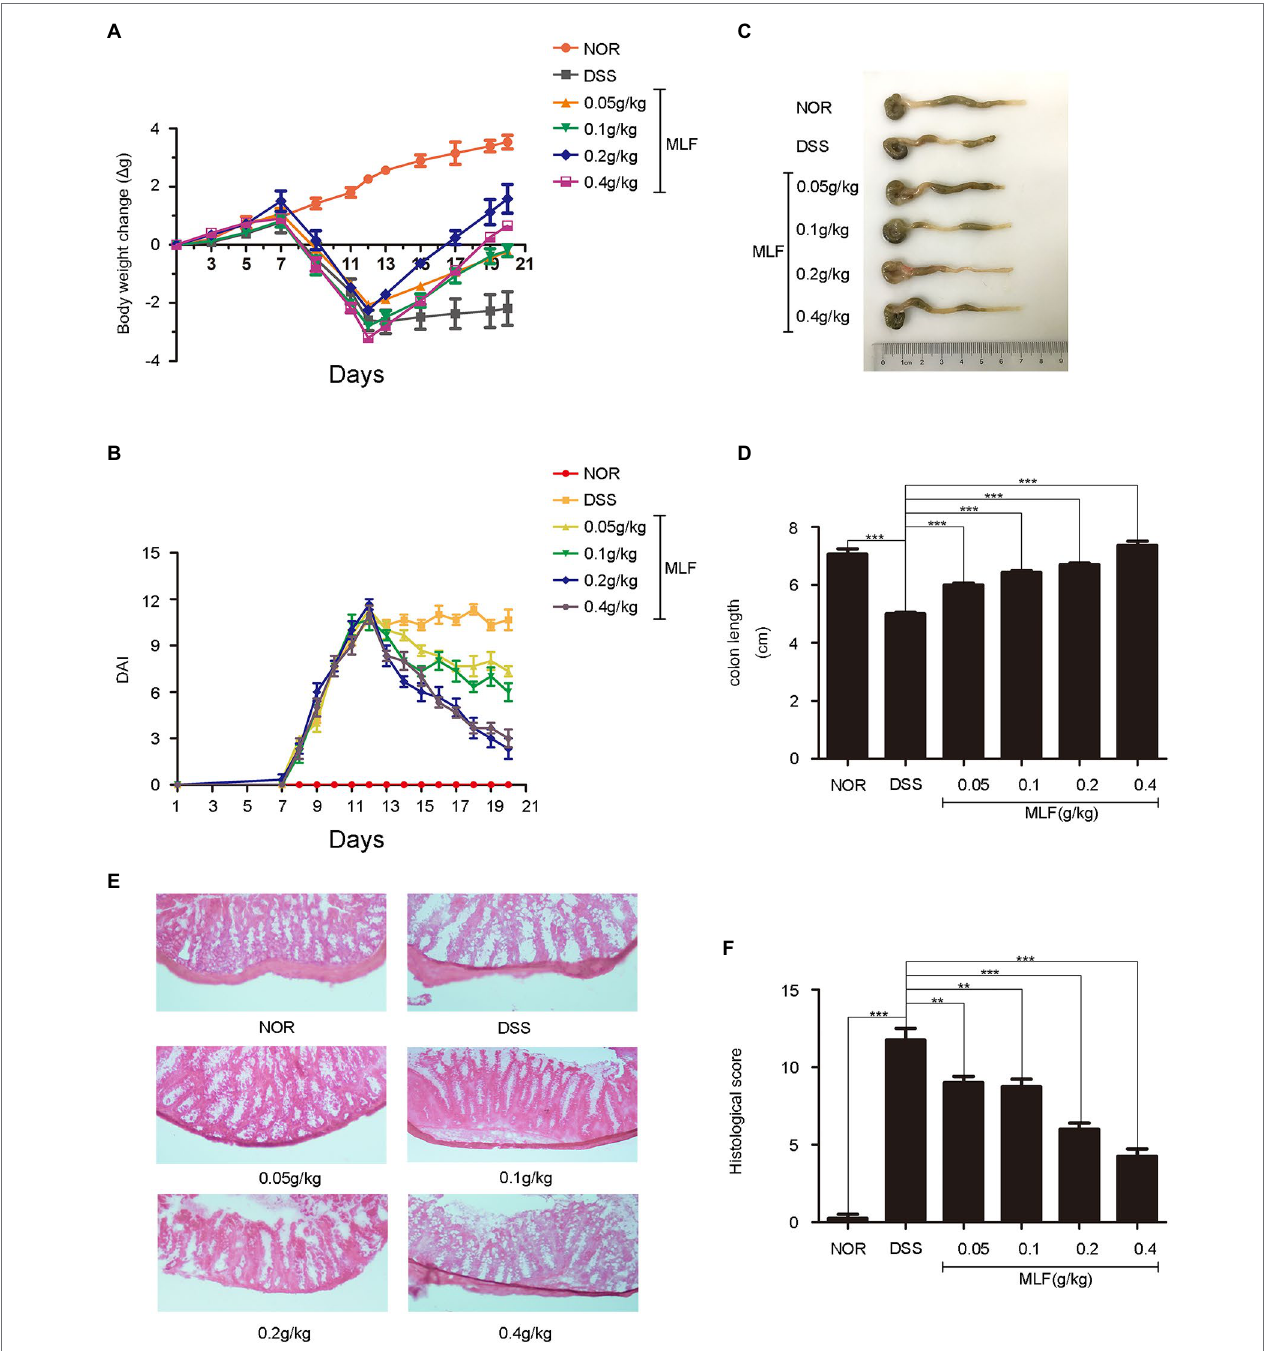
FIGURE 5 | Improvement of symptoms in dextran sodium sulfate (DSS)-induced colitis by MLF. (A) The body weight change was evaluated throughout the experiment and expressed as the weight change relative to the previous day. (B) Disease activity index (DAI) score was examined every day. (C) The photos of colon length (one representative colon from each group). (D) The colon lengths calculated from (C) . All groups were statistically analyzed with the DSS group. (E) The distal colon was stained with hematoxylin and eosin to determine the degree of inflammation, and (F) the histological score was measured. Data are expressed as means ± S.E. ** p < 0.01 and *** p <